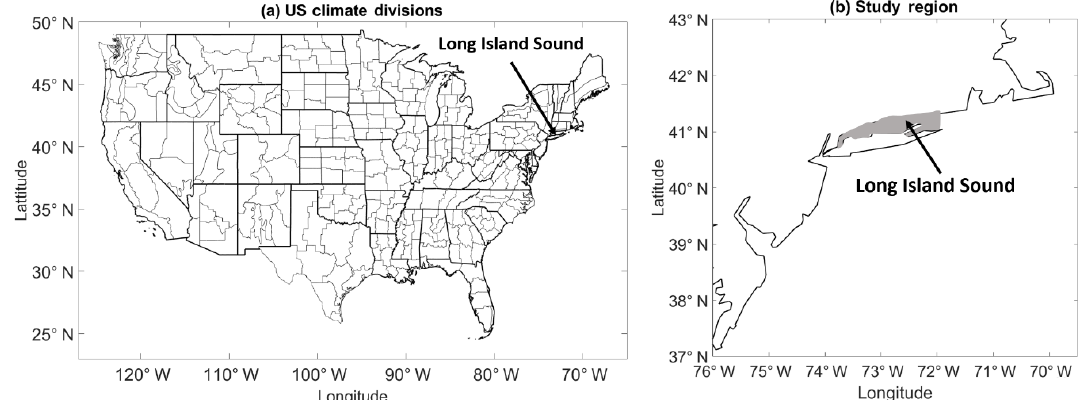
Figure 1. (a) The 344 US climate divisions and (b) the LIS study region. Gray shading delineates the region used to calculate the LIS surface water temperature time